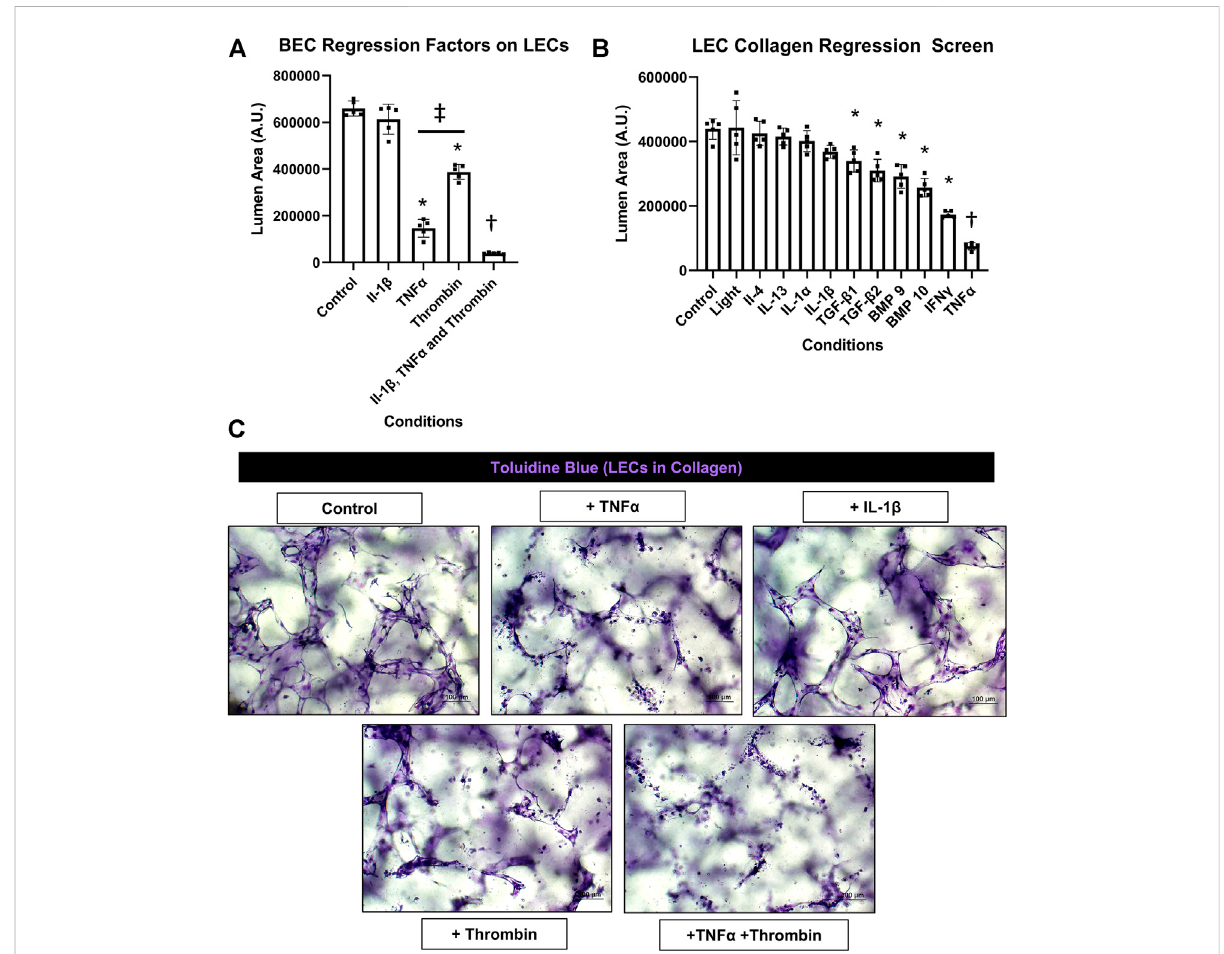
FIGURE 2 Identi fi cation of proin fl ammatory mediators that induce lymphatic EC tube regression in 3D collagen gels. (A,B,C) Serum-free lymphatic endothelial cell (LEC) tube networks + FIST (10 μ M forskolin, 100 μ M IBMX, 10 μ M SB239063, and 10 μ M Tubacin) formed for 48 h in a collagen gel and were then treated with the indicated individual and combinations of growth factors and cytokines for an additional 24 h. Cultures were then fi xed,stained,andphotographedtoevaluateECtubearea. (A) BloodEC(BEC)regressionfactorsonLECs.IL(interleukin)-1 β wasaddedat10 ng/ ml,TNF(tumornecrosisfactor) α wasaddedat10 ng/ml,thrombinwasaddedat1 μ g/ml. (B) LECcollagenregressionscreen.Light,IL(interleukin)-4, -13, -1 α , -1 β , TGF (transforming growth factor)- β 1 and 2, BMP (bone morphogenic protein)-9, -10, IFN (interferon) γ , TNF (tumor necrosis factor) α were all added at 10 ng/ml. (C) 3D LEC cultures fi xed and stained with toluidine blue at the end of 72 h (48 h setup +24 h condition treatment). Bars equals 100 μ m; n ≥ 5; * p ≤ 0 .05 to control, † indicates p ≤ 0.05 signi fi cance from all other conditions, ‡ indicates p ≤ 0 .05 between indicated conditions. Analyzed using one-way ANOVA with post hoc Tukey